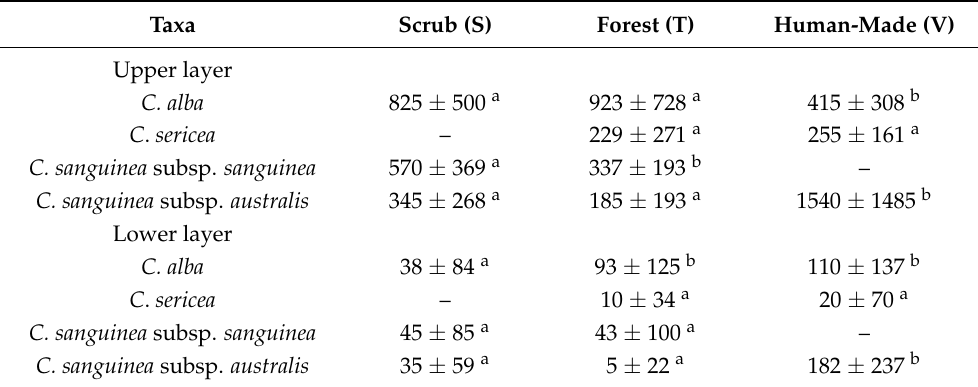
Table 8. Number of intact seeds of Cornus taxa in different habitats in the upper (0–5 cm) and lower (5–10 cm) soil layer. Different letters indicate significant differences ( p < 0.05) applying Dunn’s post hoc z -test. S—Heathlands, scrub and tundra; T—Forests and other wooded land; V—Vegetated human-made